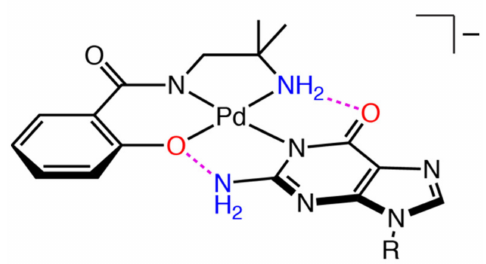
Figure 11. Chemical structure of Pd-G anion (R indicates the ribose moiety). Hydrogen-bond donor and acceptor are shown in blue and red, respectively. Dashed lines in magenta indicate intramolecular hydrogen bonds.